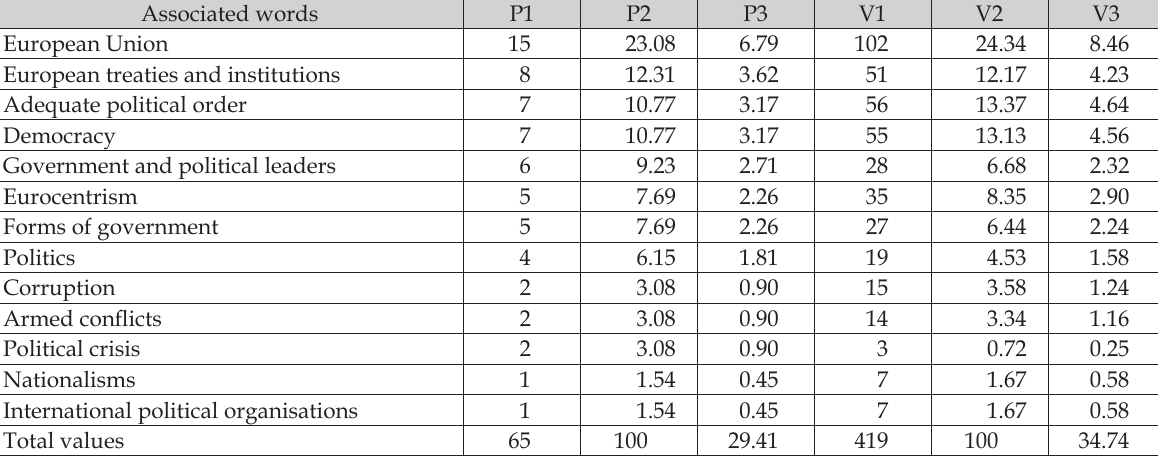
Table 3. Categories shaping the semantic field on political realities and interpretations after an associated word test on students in training to be secondary education